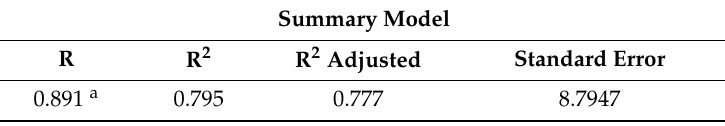
Table 8. Determination coefficients for wheel-tracking test and first modulus of PLT ( ɸ 600mm) at crown.